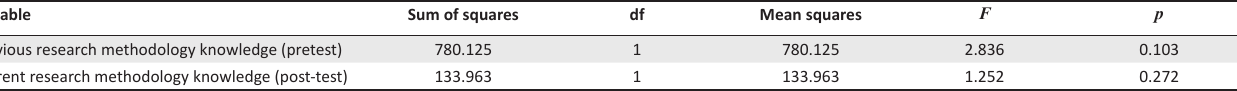
TABLE 6: One-way analysis of variance results for prior training as independent variable and previous and current research methodology knowledge as dependent variable. Variable Sum of squares df p Previous research methodology knowledge